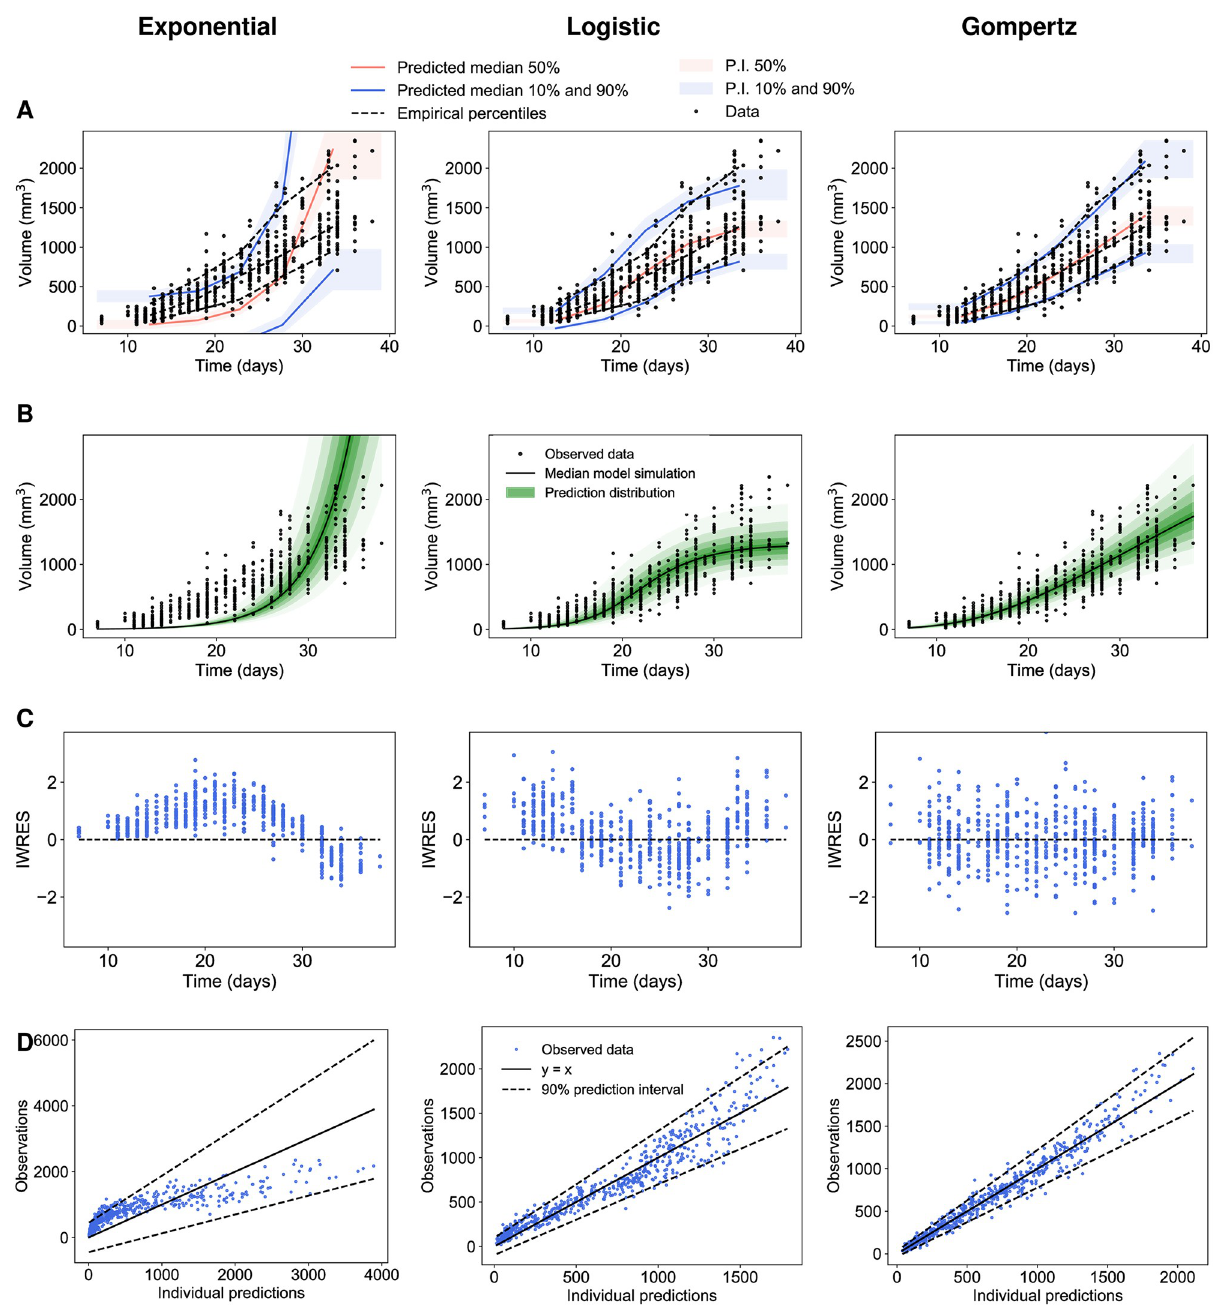
Fig 1. Population analysis of experimental tumor growth kinetics. (A) Visual predictive checks assess goodness-of-fit for both structural dynamics and inter-animal variability by reporting model-predicted percentiles (together with confidence prediction intervals (P.I) in comparison to empirical ones. They were obtained by multiple simulations of each model. The time axis was then split into bins and in each interval the empirical percentiles of the observed data were compared with the respective predicted medians and intervals of the simulated data [47]. (B) Prediction distributions. They were obtained by multiple simulations of all individuals in the dataset, excluding the residual error [47]. (C) Individual weighted residuals (IWRES) with respect to time. (D) Observations vs predictions Left: exponential, Center: logistic, Right: Gompertz models.